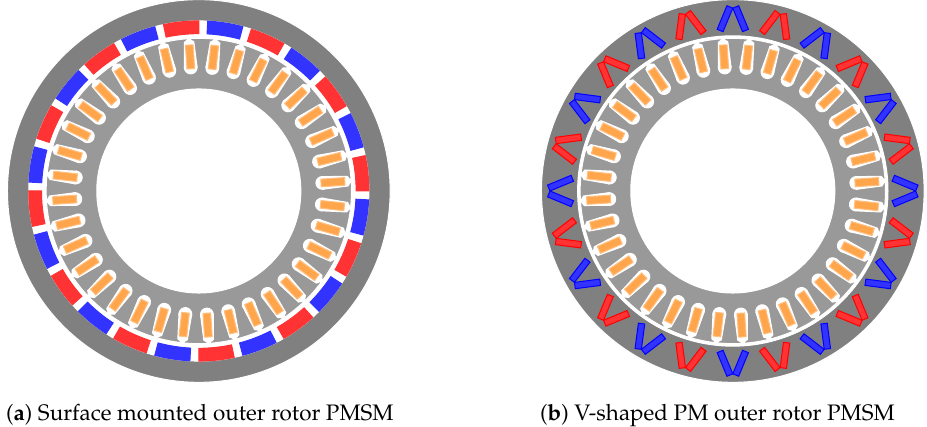
Figure 5. Motor topology of ( a ) Surface-mounted OR-PMSM ( b ) V-shaped Interior PM OR-PMSM.